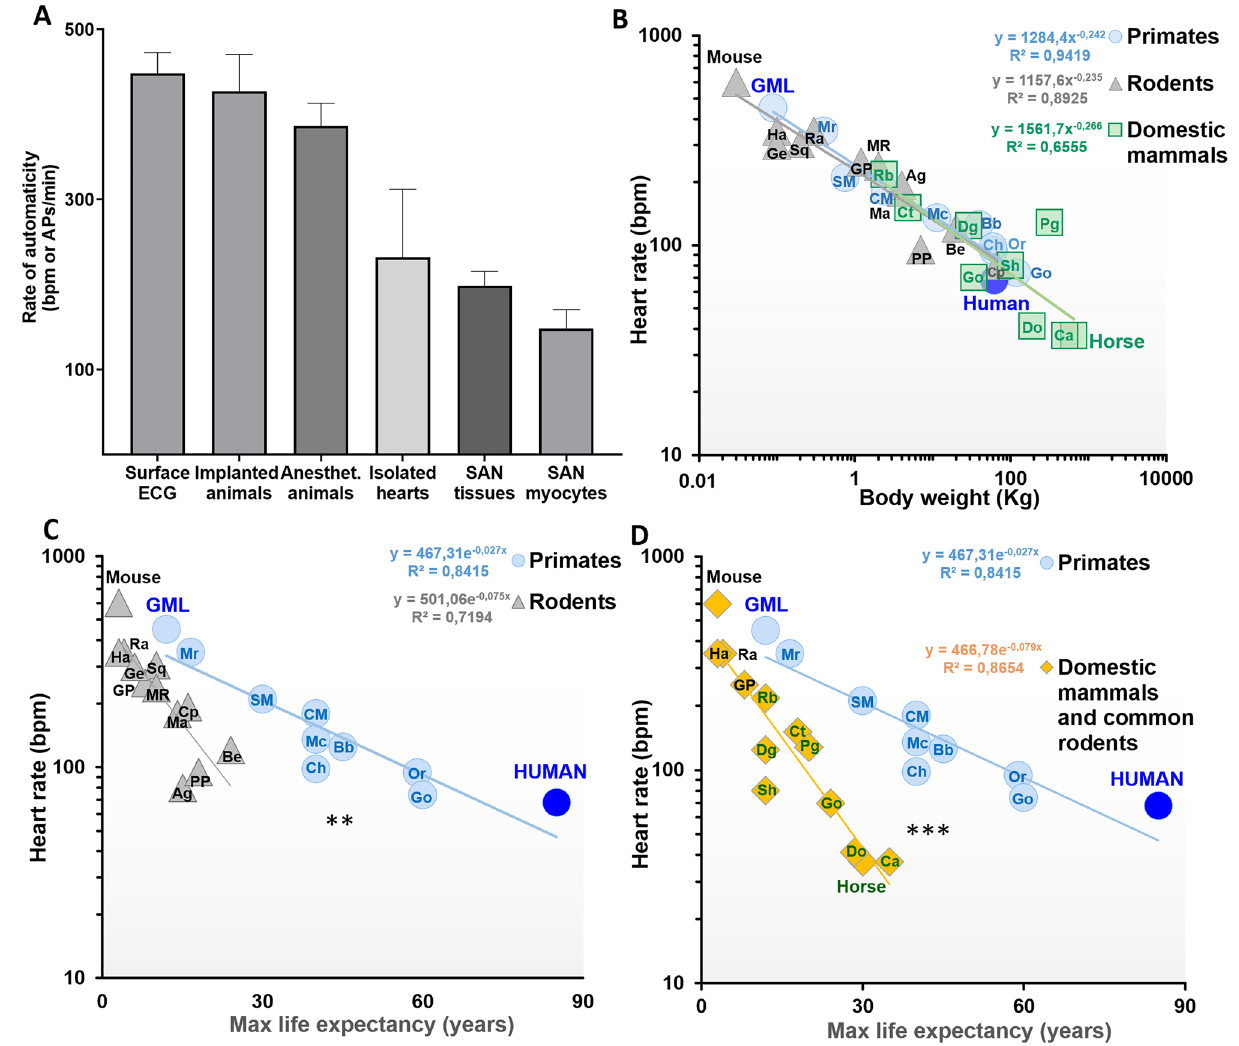
Figure 5. Hierarchical scaling of GML cardiac automaticity and HR versus body weight and life expectancy in primates, rodents and other mammals. ( A ) Decrease of automatic rate at different levels of complexity, going from freely moving animals to single SAN myocytes of GML (n = 13 for surface ECG, n = 4 for implanted animals, n = 6 for anesthetized animals, n = 3 for isolated hearts, n = 16 for SAN tissues and n = 7 for SAN myocytes). ( B ) Correlation between HR and body weight for 10 species of primates, including humans 55 , 12 species of rodents and 9 species of common domestic mammals. Names of the different species are abbreviation as following: Mr = common marmoset, SM = squirrel monkey, CM = capuchin Monkeys, Mc = rhesus macaque, Ch = chimpanzee, Bb = babouin hamadryas, Orang = orangutan, Go = gorilla, Ha = hamster, Ge = Mongolian gerbil, Ra = rat, GP = guinea pig, Sq = north american red squirrel, MR = muskrat, Ma = marmot, Cp = capybara, Ag = agouti, PP = North American Porcupine, Be = north american beaver, Rb = rabbit, Ct = Cat, Sh = sheep, Go = goat, Dg = dog, Pg = pig, Do = donkey and Ca = camel (see methods for each animal reference and scientific name). The correlation for the three distributions is verified by the Spearman analysis (p < 0.001 for primates and rodents, and p < 0.05 for domestic mammals) and the slopes and the intercept of the three logarithmic linear distributions are not significantly different by the covariance (ancova) analysis. ( C ) Correlation between HR and maximal life expectancy for 10 species of primates, including GML and humans 55 , and 12 species of rodents reported in panel ( B ). The correlation for both distributions is verified by the Spearman coefficient (p < 0.001 for primates and rodents) and the slopes of the two semi-logarithmic linear distributions are significantly different by the covariance (ancova) analysis, with p < 0.01. ( D ) Correlation between HR and maximal life expectancy for 10 species of primates, including GML and humans 55 , and 13 species of common domestic mammals reported in panel ( B ). The correlation for both distributions is verified by the Spearman coefficient (p < 0.001 for primates and eutherian mammals) and the slopes of the two semi-logarithmic linear distributions are significantly different by the covariance (ancova) analysis, with p <